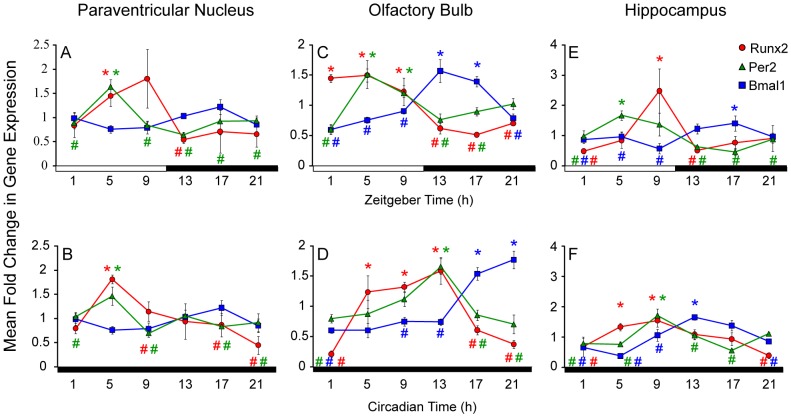
Runx2 gene expression is rhythmic in the brain regions outside of the SCN.The paraventricular nucleus, the olfactory bulb and the hippocampus tissues were assayed fewer than 12∶12 h LD (A, C and E) and 24 h DD (B, D and F) conditions. Fold changes in levels of gene expression (± SEM) for Runx2 (red circle), Per2 (green triangle) and Bmal1 (blue square) determined by real-time qRT-PCR. In 12 h∶12 h LD conditions, time of day is represented by white and black horizontal bars indicating periods of day and night, respectively, with dark onset marking ZT12. In 24 h DD conditions, grey and black horizontal bars represent subjective day and night, respectively, with running wheel activity onset marking CT12. Significant peaks levels of expression (*) compared to nadir points (#) for given gene presented in respective color (p<0.05).